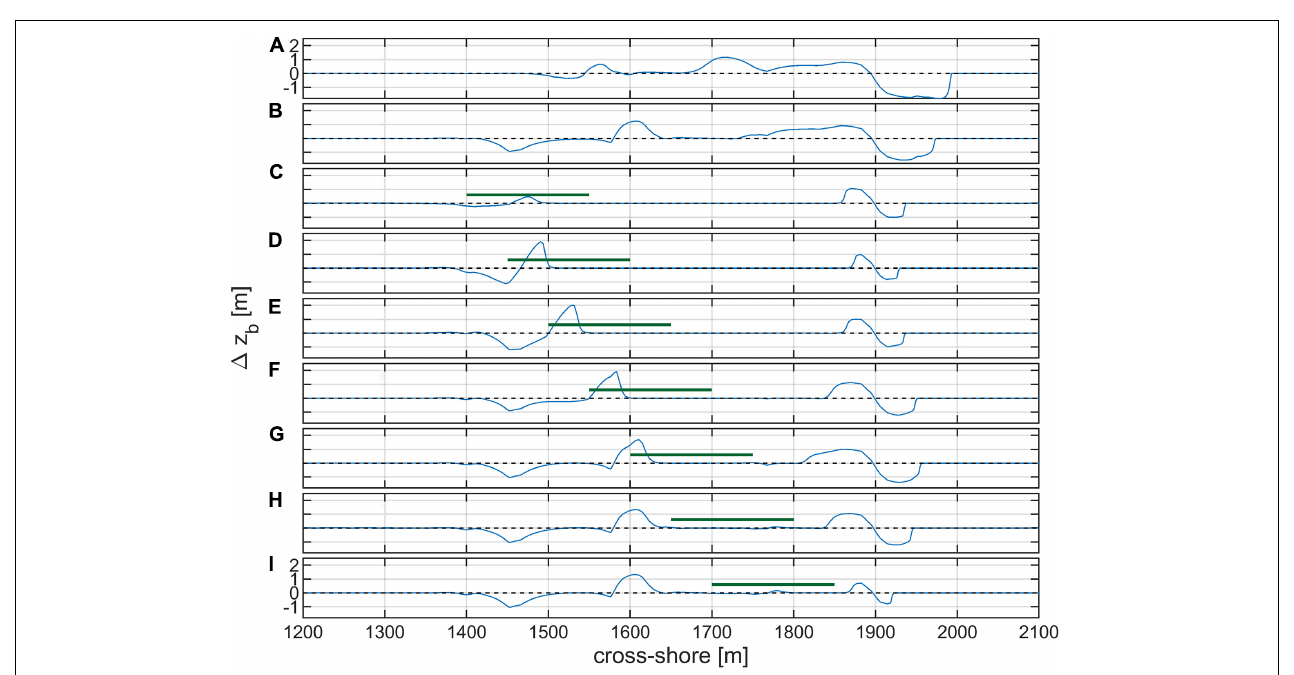
FIGURE 7 | Change of seabed under mild wave condition for 100 days, showing: (A) REF seabed; (B) SN bed; (C–I) GN1-7. Green horizontal line indicates the location of the seagrass meadow.